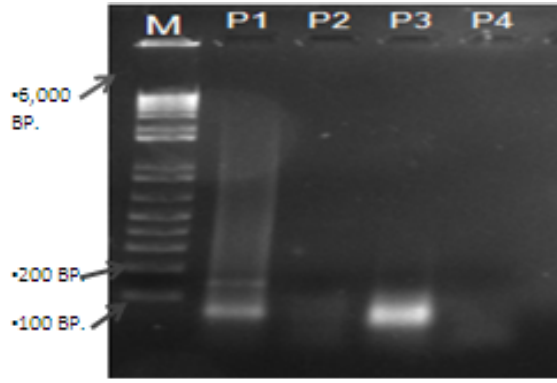
Figure 1 : Different incubation times in cell lysis for pork was; Molecular market 1kb Plus (M); (15min (P1), 30min (P2) 45min (P3), 60min